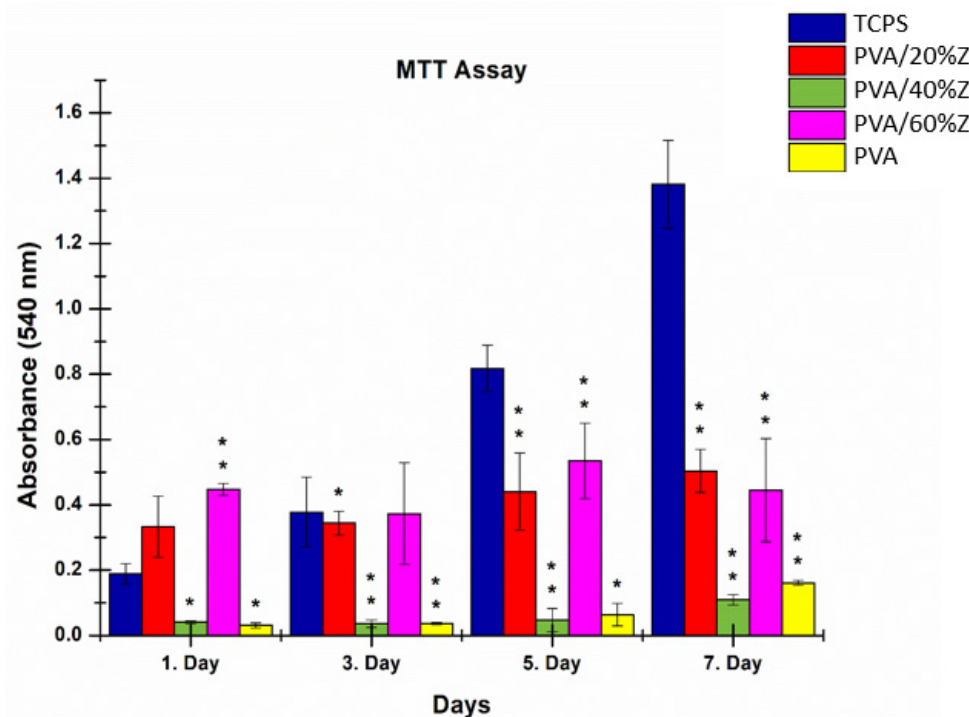
Figure 8. Viability of L929 cells cultured on pure PVA and 20, 40, and 60% ZnO included PVA electrospun fibers. Statistical significance ‘ p ’ is shown as p < 0.05 = ‘*’, p < 0.01 = ‘**’.